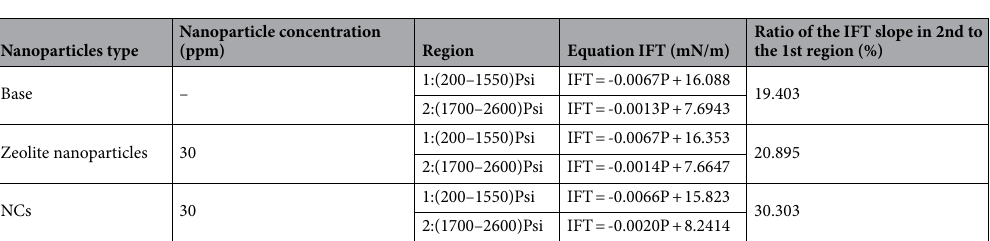
Table 6. Changes in CO 2 -oil IFT slope ratio in the presence of NCs and zeolite nanoparticles.